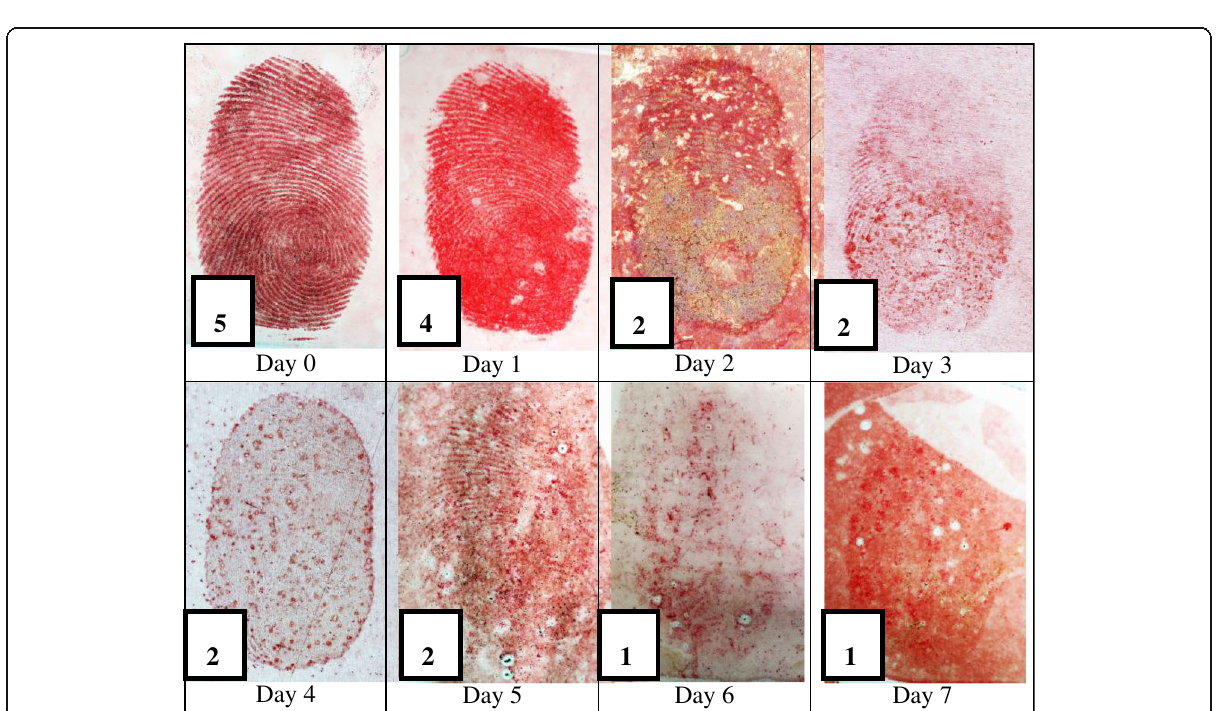
Fig. 10 Developed fingermarks by using oil red